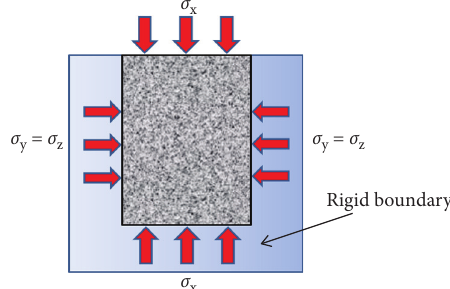
Figure 1: Compression with uniaxial strain